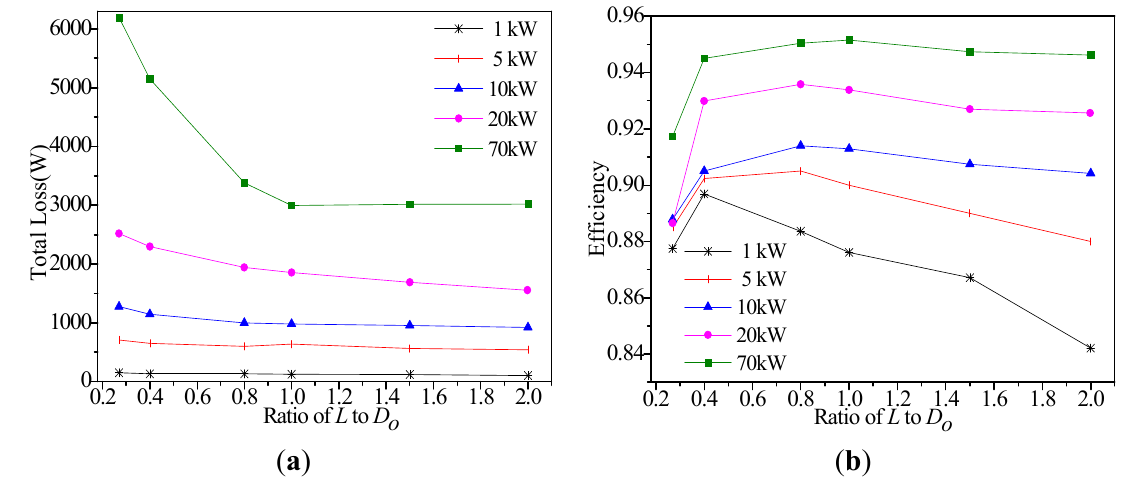
Figure 5. Influences of the ratio k on ( a ) total loss; and ( b )